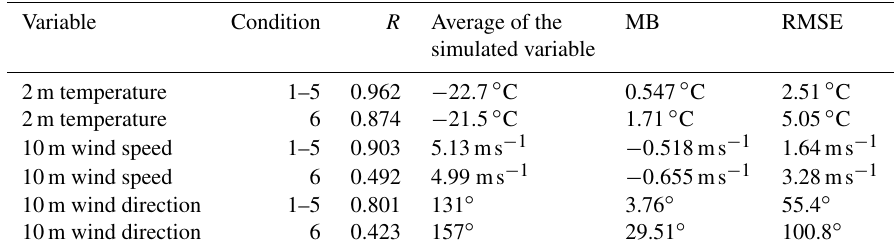
Table 3. Meteorology statistics at Utqia˙gvik.